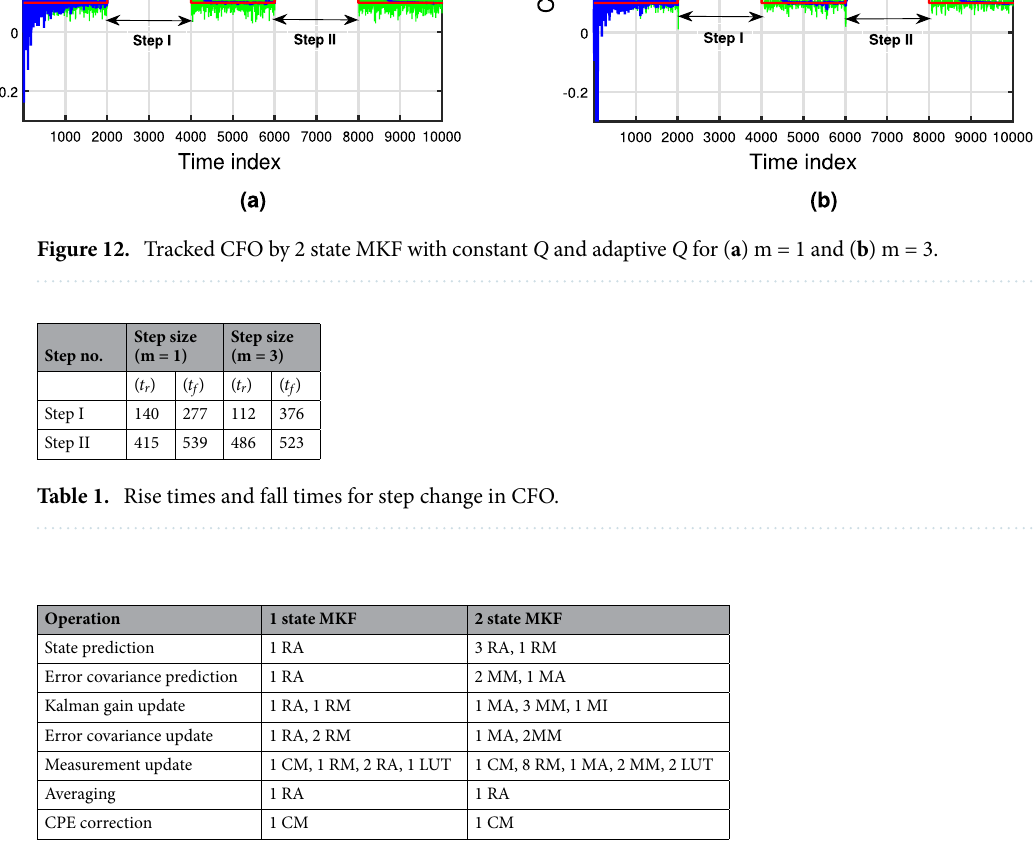
Table 2. Computational complexity for 1 state and 2 state MKF. RA, real addition; RM, real multiplication; MM, matrix Multiplication; MA, matrix addition; MI matrix inversion; CM complex multiplication; LUT lookup